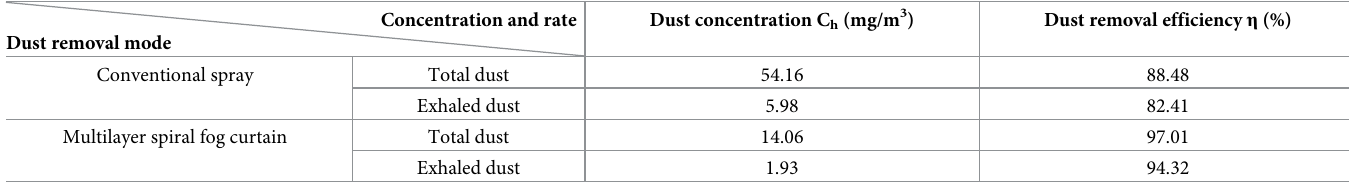
According to the data in Table 3, when the traditional spray dust removal method is adopted, the concentrations of total dust and exhaled dust at the measuring points are con- trolled at 54.16 mg/m 3 and 5.98 mg/m 3 , respectively, and the dust removal efficiency is 88.48% and 82.41%, respectively. However, when the multilayer spiral fog curtain is used for dust removal, the dust removal efficiency of the total dust at the measuring point is as high as 97%, the dust removal efficiency of the exhalation dust is close to 95%, and the concentrations are controlled at 14.06 mg/m 3 and 1.93 mg/m 3 . It can be clearly seen that the dust removal effi- ciency of the multilayer spiral fog curtain is higher. Compared with the traditional spray dust removal efficiency, the dust removal efficiency of multilayer fog curtains is approximately 10% Table 4. Dust concentration and efficiency of two groups of tests after continuous dust emission.